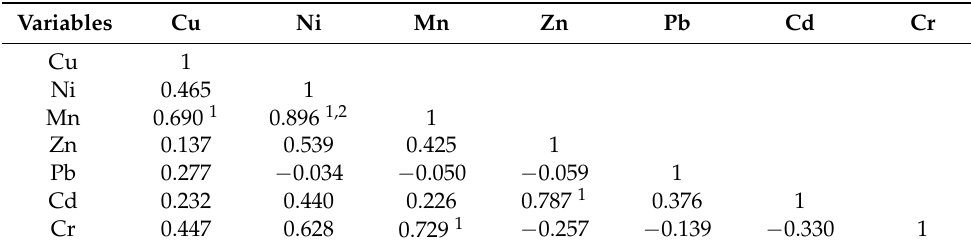
Table 3. Pearson’s bivariate correlation matrix for PTEs in dust from Eastern Uganda. Variables Cu Ni Mn Zn